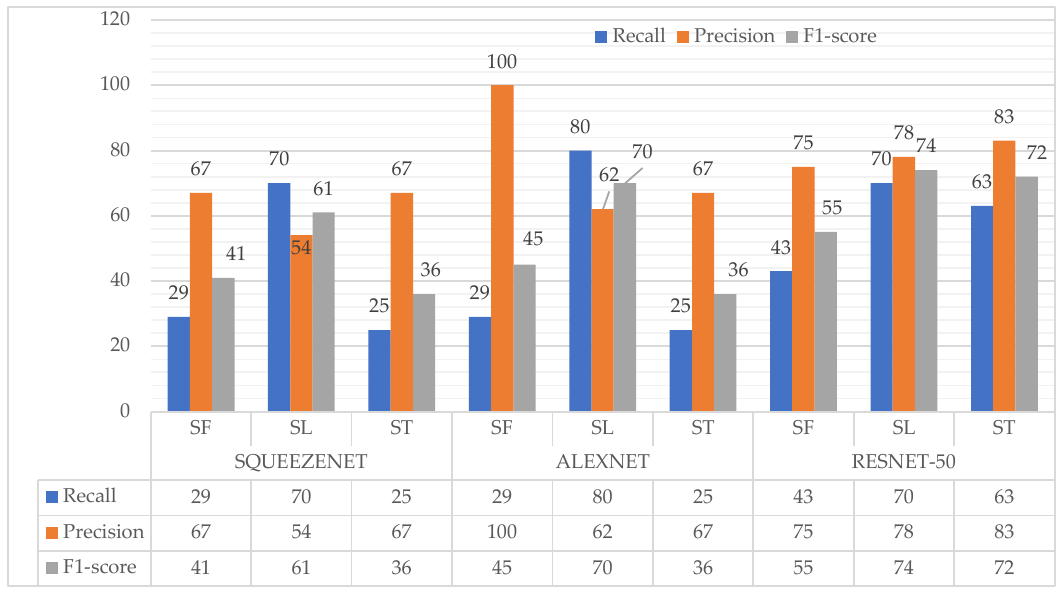
Figure 11. Performance of sago palm classifier in percentage (%).